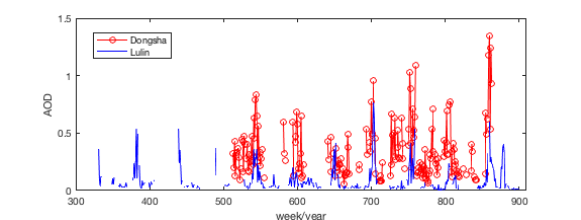
Figure 2. Measured AOD from the NASA AERONET network stations at Lulin (blue line) and Dongsha Island (red circles).